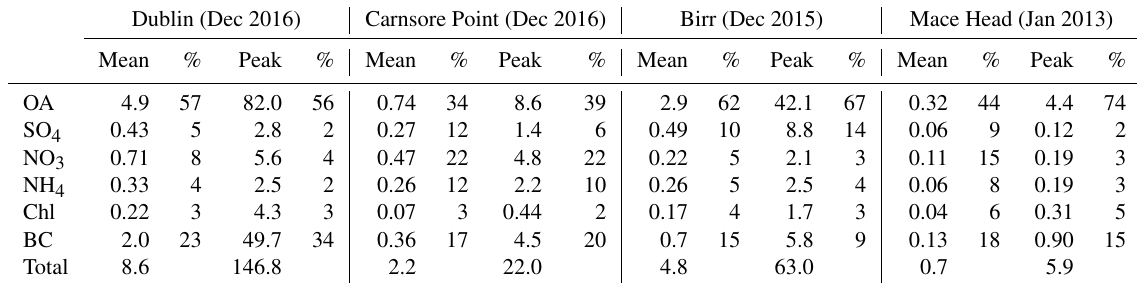
Table 1. Average and peak concentrations of organic aerosol (OA), sulfate (SO 4 ), nitrate (NO 3 ), ammonium (NH 4 ), chloride (Chl), and black carbon (BC), as well as relative contribution (%) to total PM 1 at the four measurement sites across